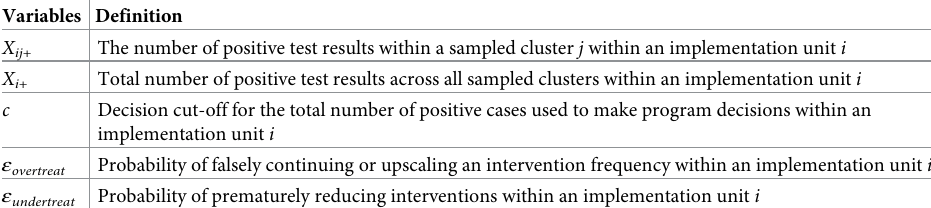
Table 2. Definitions of the derived variables that describe the 2-stage LQAS